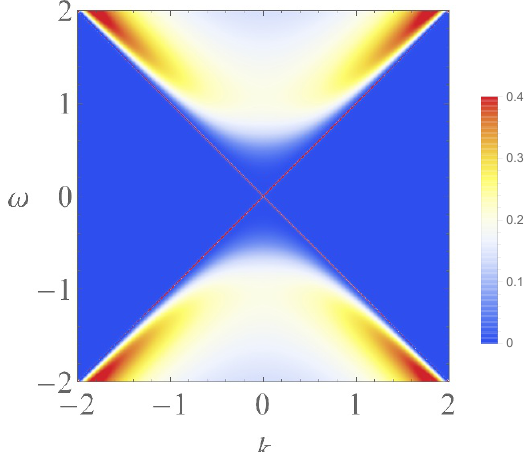
Figure 6 . The spectral function at (cid:21) = 1 and g = g c = 0 : 56.